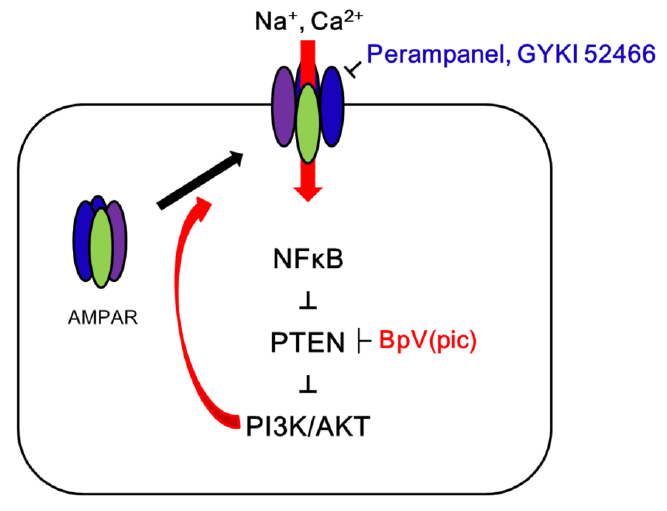
Figure 8. Scheme of the role of GRIA1 activation in epileptic rats. In the epilepsy hippocampus, α-amino-3-hydroxy-5-methyl-4-isoxazolepropionic acid receptor (AMPAR) hyperactivation leads to spontaneous seizure activity, which results in NF- κ B-mediated PTEN downregulation. Subsequently, the reduced PTEN expression deregulates PI3K / AKT1 pathway that facilitates GRIA1 tra ffi cking. Blockade of AMPAR by perampanel or GYKI 52,466 inhibits this signal cascade, which is abrogated by BpV(pic). Therefore, the present study demonstrates that PTEN may be required for the anti-epileptic e ff ects of AMPAR